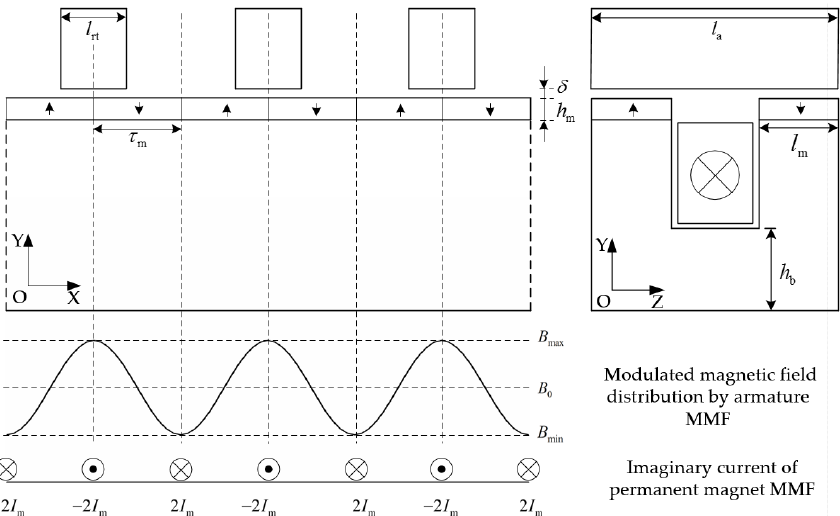
Figure 3. Magnetic field distribution by the armature magnetomotive force (MMF) and imaginary current distribution equivalent to the permanent magnet MMF.